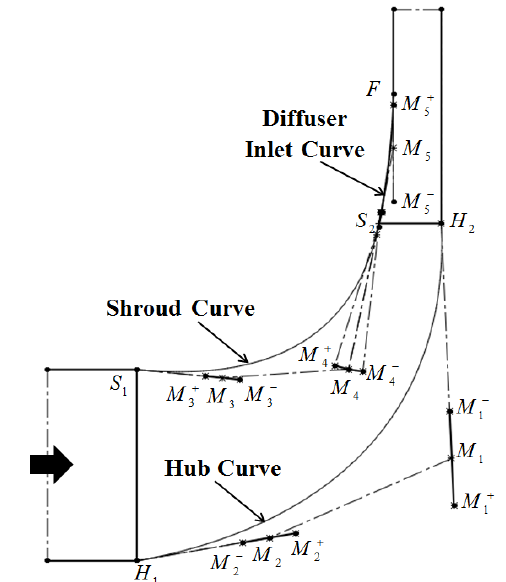
Figure 3. Parameters and their levels in Stage